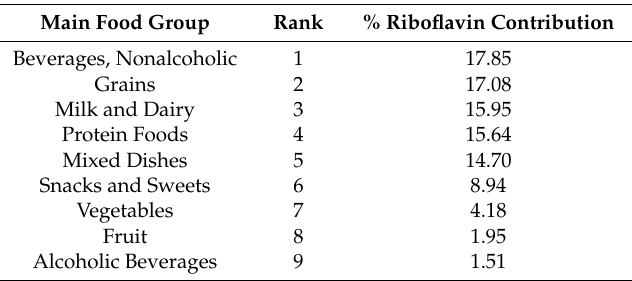
Table 19. Food sources of riboflavin contribution in the total U.S. diet, adults ≥ 51 years old ( n = 4522; gender combined; daily intake data; NHANES 2011–2014; main food groups contributing <1.0% not reported; data are Day 1 intakes).